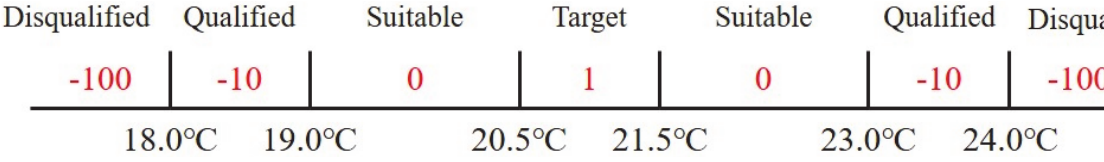
Figure 5. Design of reward function 1.